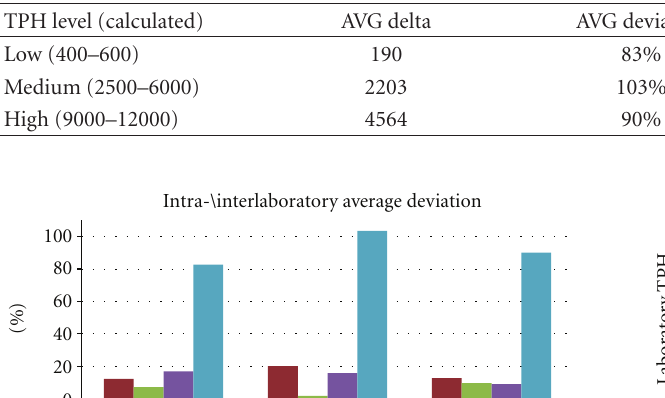
Table 4: Interlab repetition statistics for low, medium, and high TPH levels.